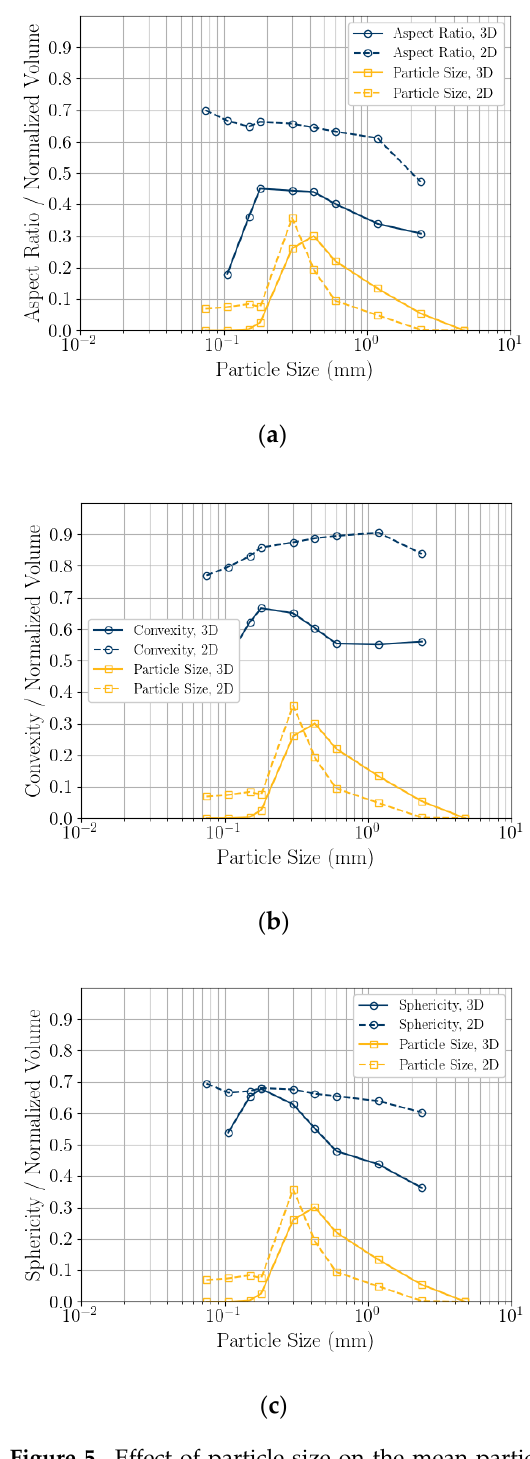
Figure 5. Effect of particle size on the mean particle shape: aspect ratio ( a ), convexity ( b ), and sphericity ( c ). The particle size distribution is provided as a normalized probability density plot, histogram. The mean particle shape parameters were calculated from bins where the edges were set at the sieve opening sizes listed in Table 3.